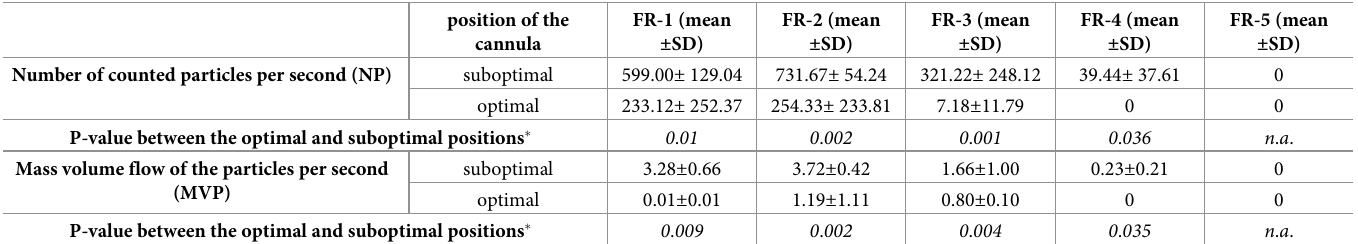
position of the cannula